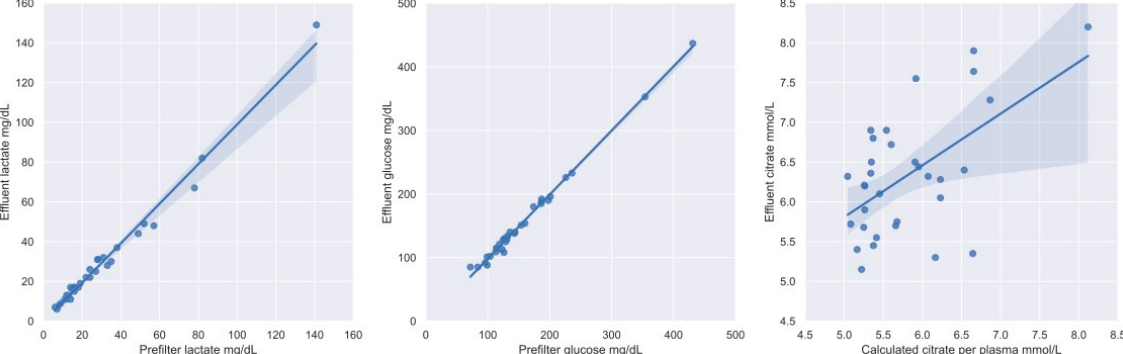
Figure 3. Linear regression models with 95% confidence intervals of prefilter lactate and lactate in effluent, prefilter glucose and glucose in effluent, and calculated citrate per plasma and citrate in effluent, respectively.